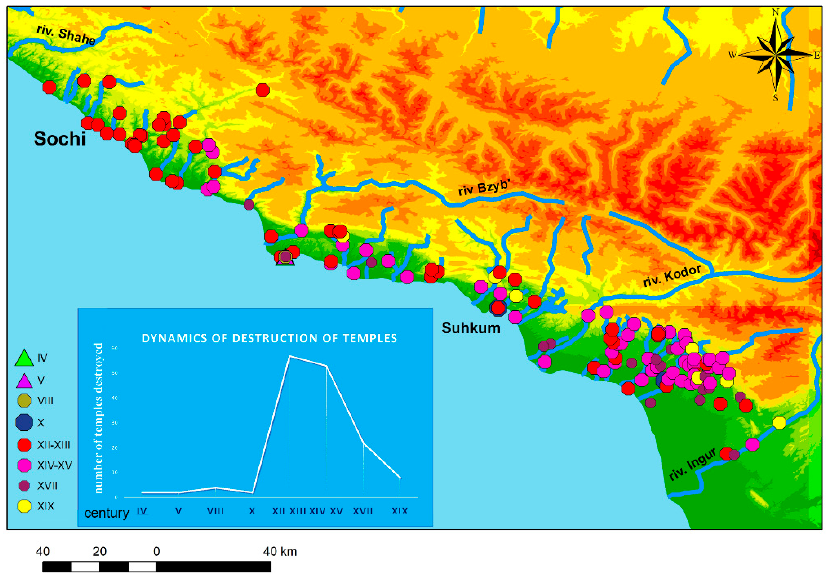
Figure 3. Map of temples with a chronological classification according to the date of destruction of the temple.